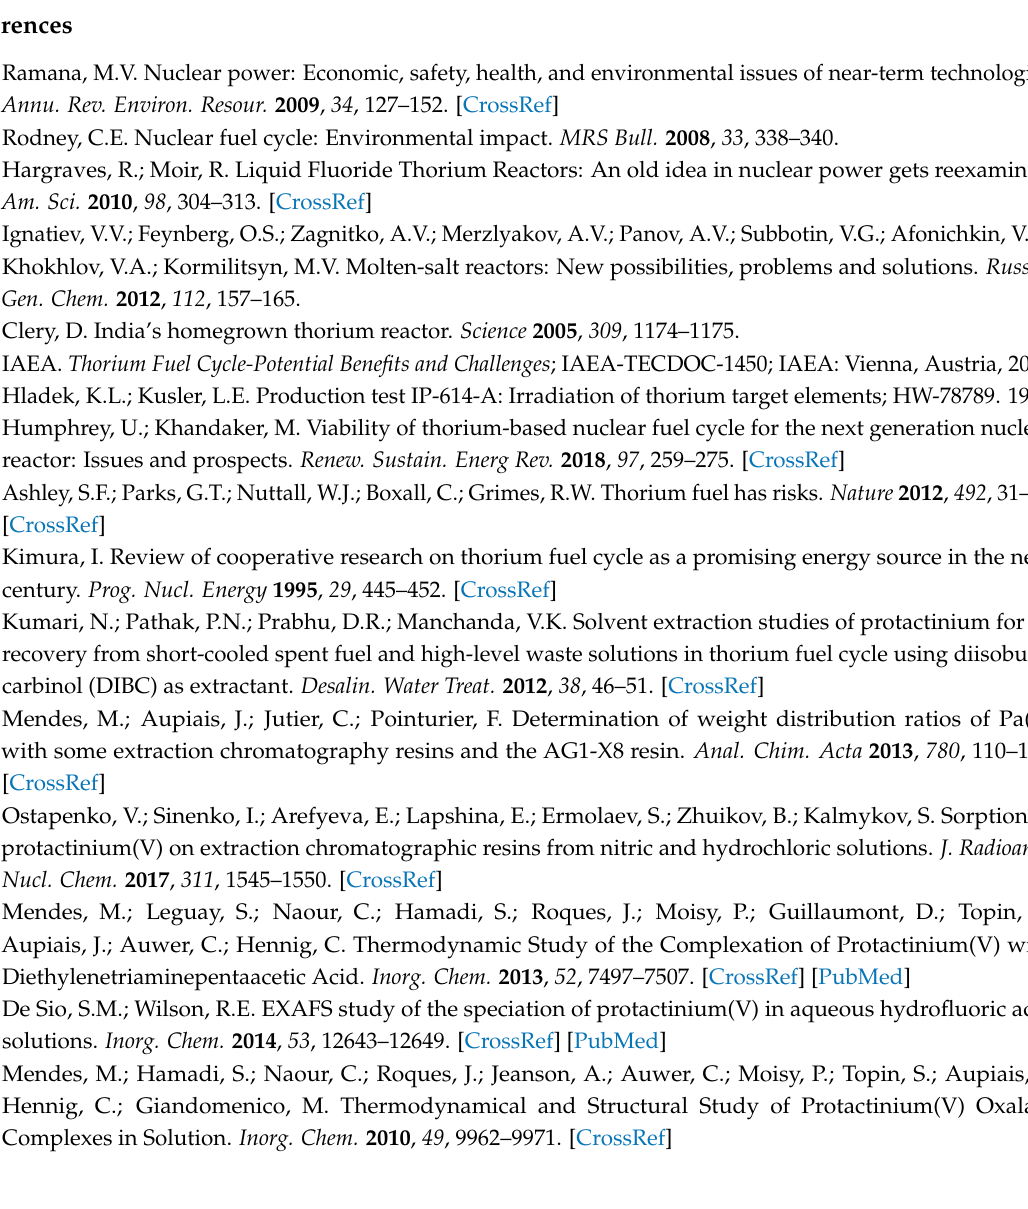
Table S1: Analysis of WBI and the NBO Charges of [PaO(H 2 O) 6 ] 3+ ; Table S2: The reaction enthalpies and Gibbs free energies for the selected hydrogen transfer reactions obtained by different methods. Cartesian coordinates and thermal energies of all species in this